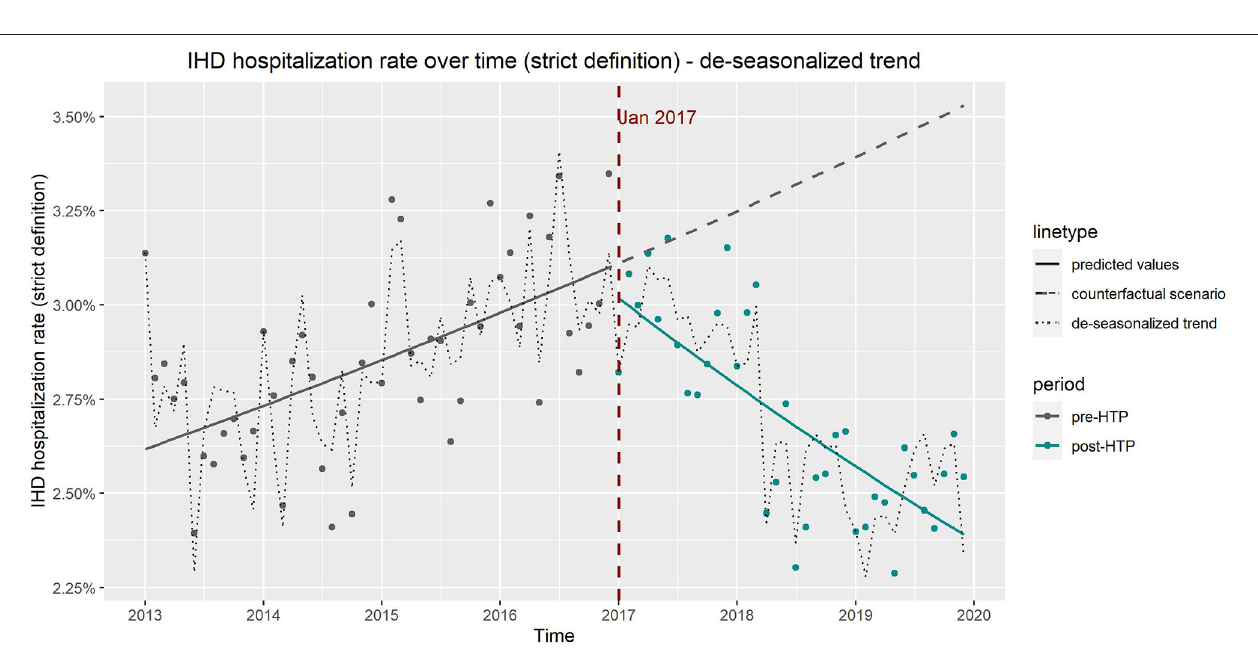
FIGURE 4 | Observed vs. expected trends in hospitalizations due to chronic obstructive pulmonary disease from results of interrupted time series model which includes age, sex, and seasonality as covariates and de-seasonalized time trend.